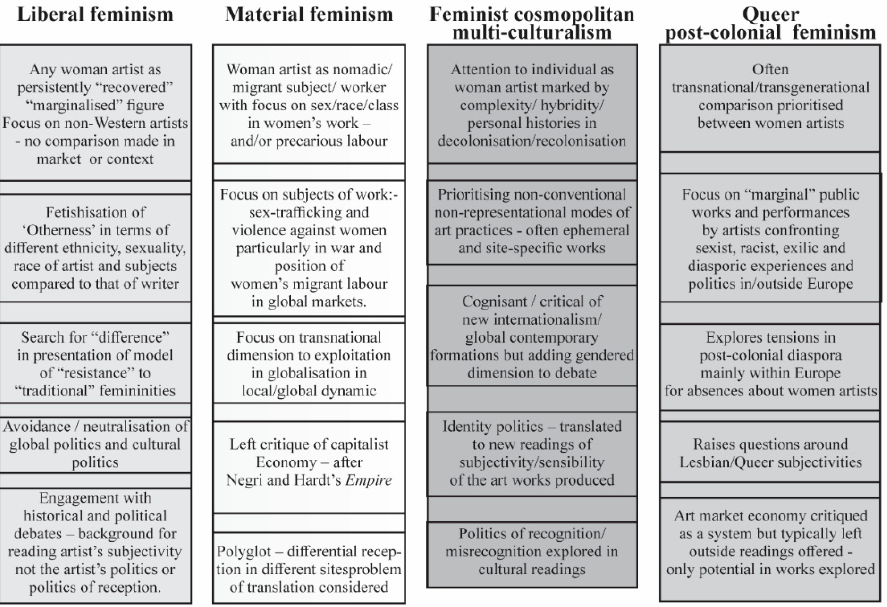
Figure 1. Katy Deepwell Map of 4 approaches in feminist art criticism.